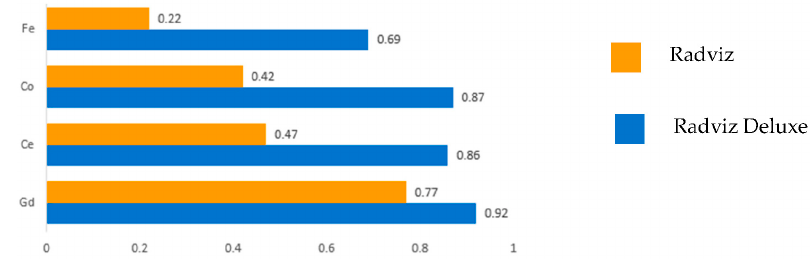
Figure 11. Distance vs. value plot for RadViz Deluxe for ( a ) Gd; ( b ) Ce; ( c ) Co and ( d ) Fe.